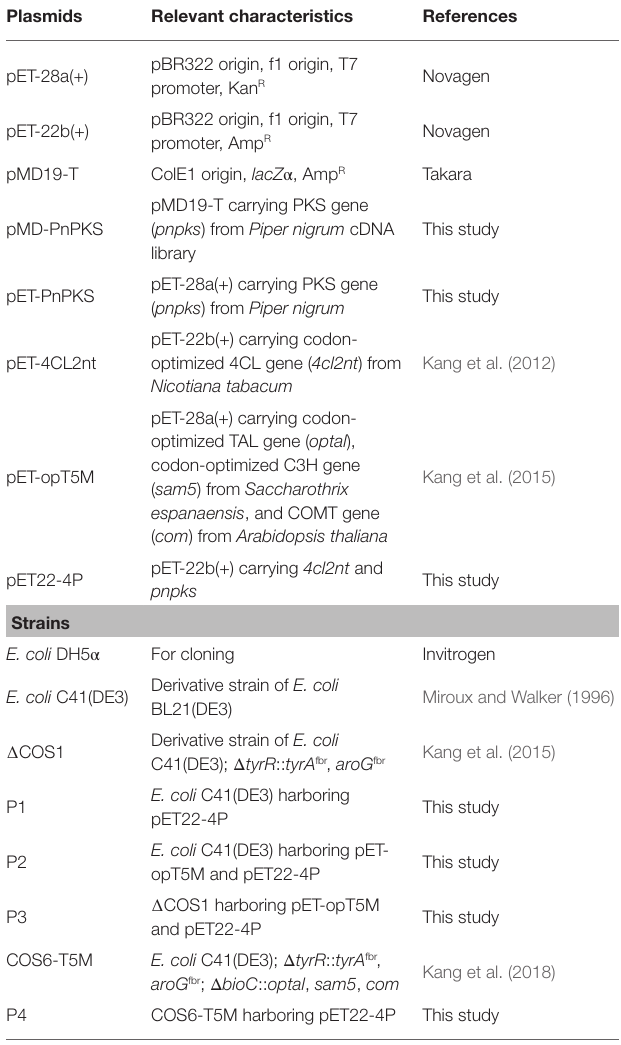
TABLE 1 | Plasmids and strains used in this study.